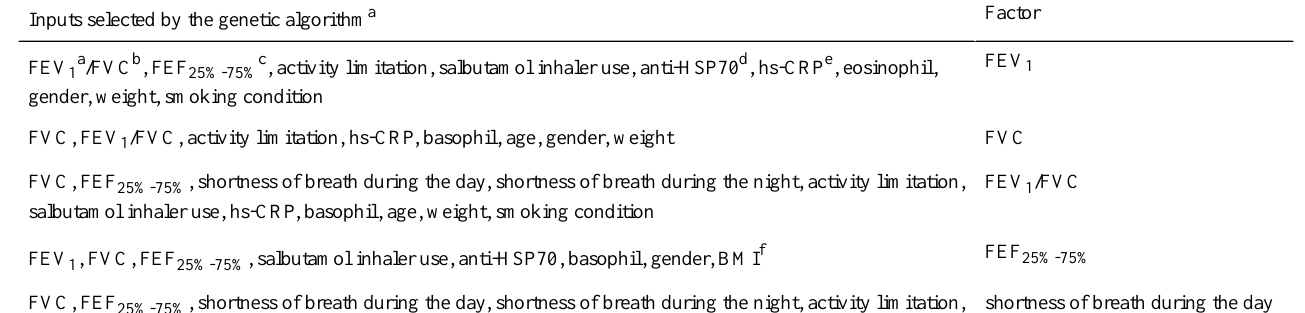
Table 3. Genetic algorithm feature selection results for prediction of risk factors. FactorInputs selected by the genetic algorithm